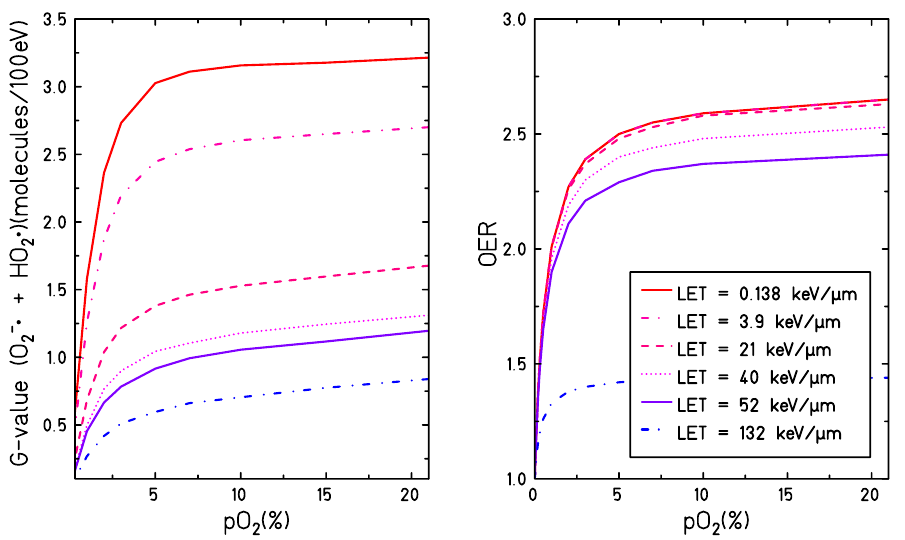
Figure 8. G-values for the production of superoxide and perhydroxyl ( left ) and oxygen enhancement ratio (OER) ( right ) are depicted as a function of target oxygenation. The OER values are calculated according to the parametrization proposed by Tinganelli et al. [3] but using definition